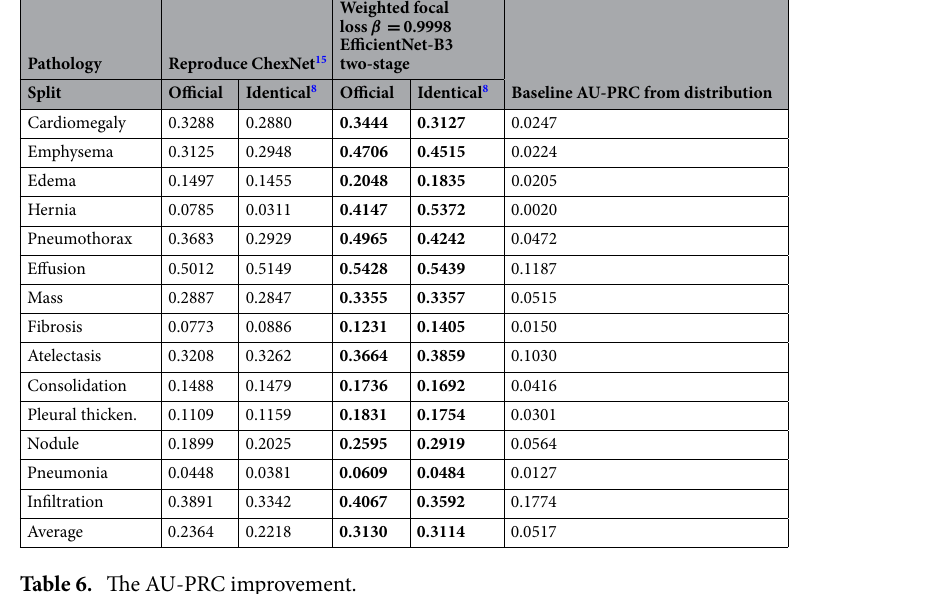
Table 6. The AU-PRC